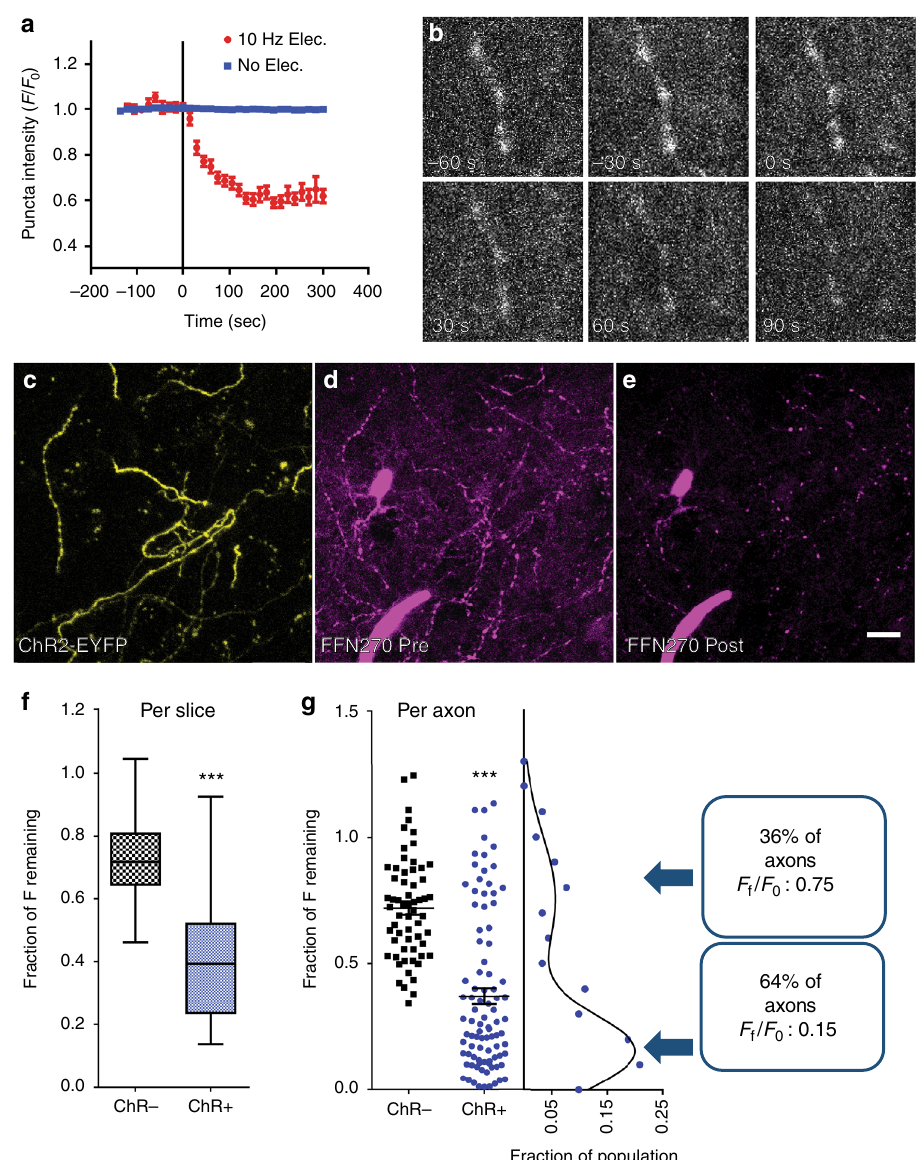
Fig. 5 Axonal FFN270 release reveals two populations of NE synapses. a Change in FFN270 puncta fl uorescence in the barrel cortex of acute slice during the course of a locally applied electrical stimulation (10 Hz, 3000 pulses, starts at t: 0 min). In red are destaining puncta identi fi ed during electrical stimulation (t- 1/2 : 34.6 s), and in blue are puncta during no stimulation ( n = 2 – 3 slices per animal, 3 animals for each condition). b A representative FFN 270 labeled noradrenergic axon during electrical stimulation. FFN270 ( d ) strongly colocalized with the ChR2-EYFP signal ( c 72.4%, 92/127 axons, 6 animals) in TH-Cre animals injected with fl oxed-ChR2-EYFP in the LC. The ChR2 was then locally stimulated with 470 nm light (10 Hz, 2400 pulses), and the change in FFN270 signal after stimulation ( e ) was measured. f When averaged across each slice, there was a signi fi cant decrease in remaining FFN270 signal that colocalized with ChR2-EYFP (ChR + , 42.6 ± 5.9%) compared to those that did not (ChR − , 72.4 ± 3.3%, P < 0.0001, two-tailed unpaired t -test, n = 2 – 3 slices per animal from 5 animals, data presented with min/max whiskers). g We also compared fl uorescence remaining of the individual axons across all trials, and observed a similar trend (ChR + : 37.1 ± 3.3%, ChR − : 72.0 ± 2.6% , P < 0.0001, Mann – Whitney). The individual axons that comprise the ChR − population follow a normal distribution (D'Agostino & Pearson test , P = 0.3), while the ChR + population does not (P = 0.003). The ChR + population closely follows a double Gaussian distribution (right panel histogram, R 2 = 0.91) with high (64% with 15.1% F remaining) and low releasing (36% with 75.4% F remaining) populations. All data listed as mean ± SEM. Scale bar: 10 µ dopaminergic FFNs 42 , by tracing neurotransmitter release at single synapse resolution, a trend of low releasing or “ silent ” P < 0.0001, two-tailed unpaired t -test, Fig. 5c – f). presynaptic sites and a separate high releasing population was + group were well We also compared the FFN release between individual NE apparent. The fl uorescent changes of the ChR fi t by the sum of two normal distributions with distinct peaks ( R 2 axons within the ChR + and ChR – populations. FFN destaining – = 0.91). While some of the ChR2 + axons (34%) only released from the noradrenergic axon population of the ChR group fi t a normal distribution (D ’ Agostino & Pearson test , P = 0.3), but the 24.6 ± 2.2% of their fl uorescent content, the majority of axons ChR + group did not (P = 0.003, Fig. 5g). As reported with (66%) almost fully destained, releasing 84.9 ± 10.9% of their